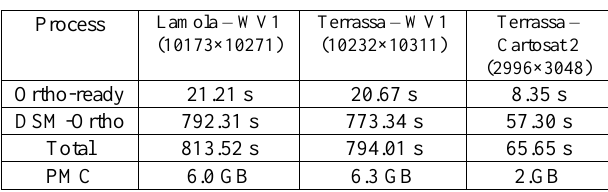
Table 3. Running time on a Normal PC (with specification listed in Table 1). Maximal Tile size: 10000 pixels. PMC : peak memory